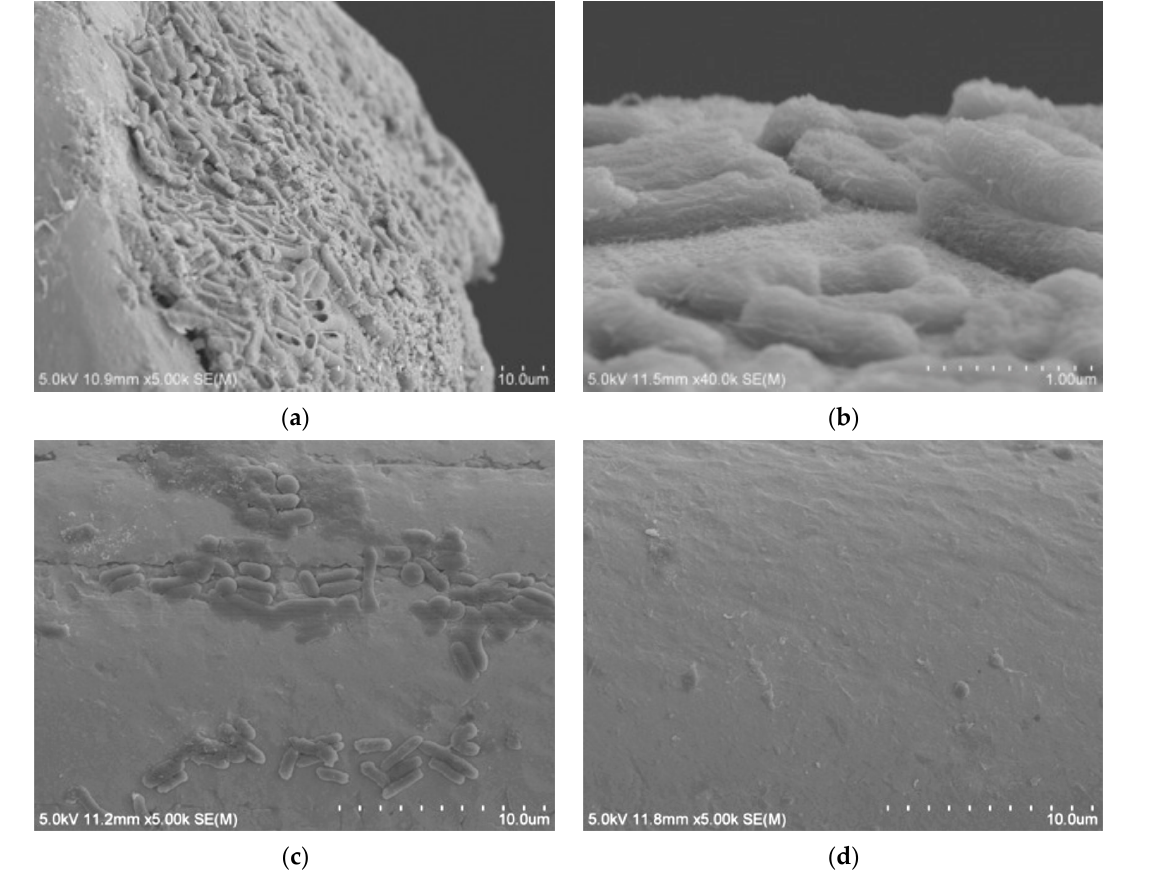
Figure 8. E. coli K12 attachment on the base plane (×5.0 k) ( a ) and the cylinder side (×40.0 k) ( b ) of microwire observed by SEM. ( c ) Bacterial attachment on the surface of the E. coli MEI sensor when applied to the cocktail solution ( E. coli K12 and S. aureus ) and ( d ) when applied to the pure S. aureus solution.